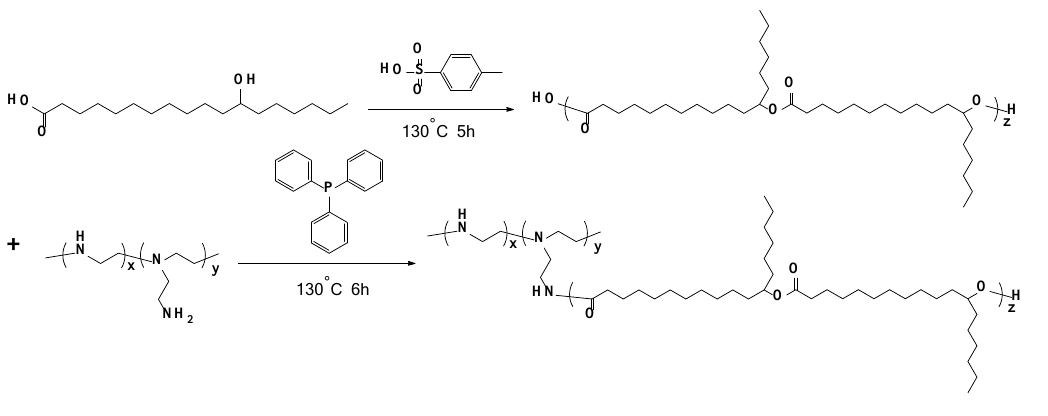
Figure 3. A synthesis route of PEPA- g -PHS.